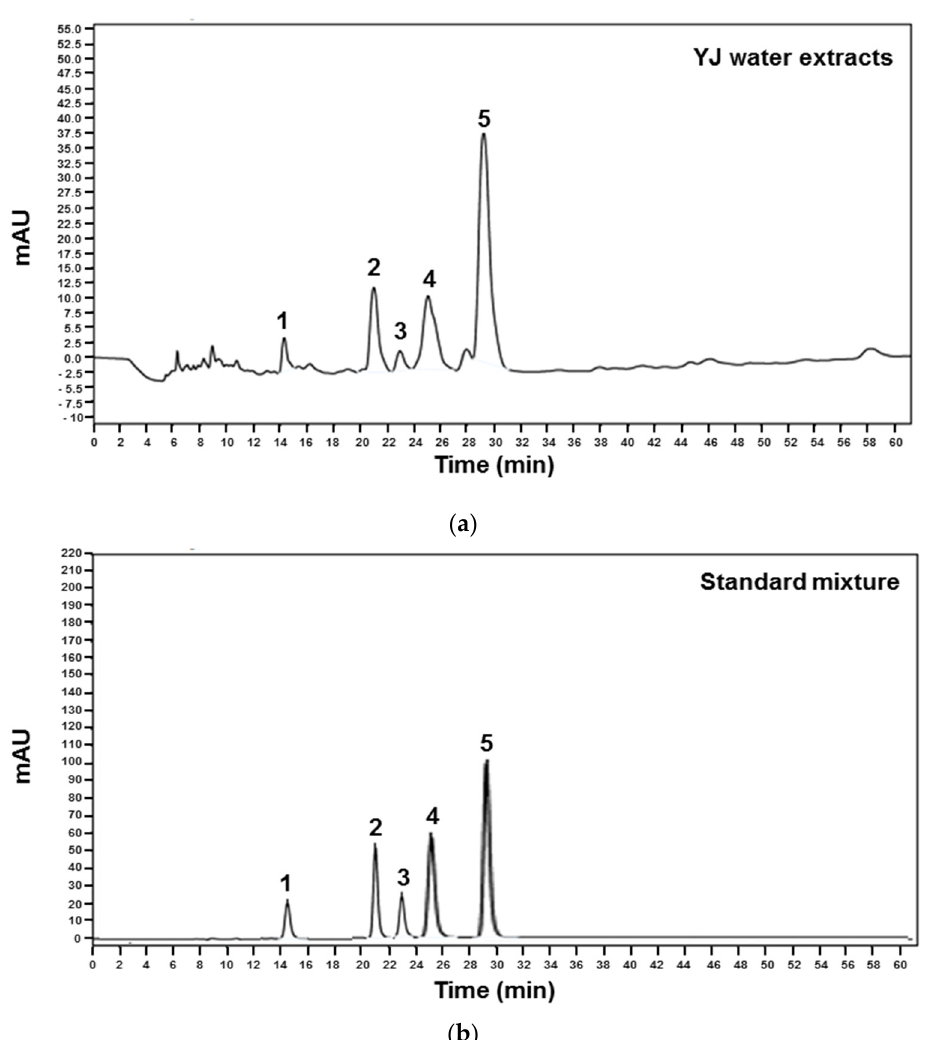
Figure 1. HPLC analysis of the YJ water extracts ( a ) and its reference standard ( b ). Peak identification: 1—Alisol A; 2—5-hydroxymethyl-2-furaldehyde (5-HMF); 3—diosgenin; 4—loganin; 5—paeonol.